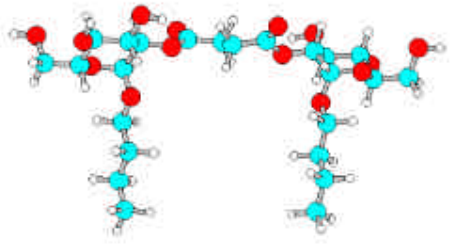
Figure 2. Optimized structure of 1,4-bis-[2- O -( n -butyl- a -D-glucopyranosid] succinate calculated by AM1